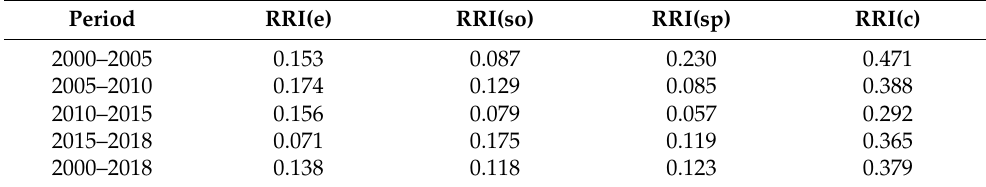
Table 3. The mean value evolution of the rural restructuring intensity index in different